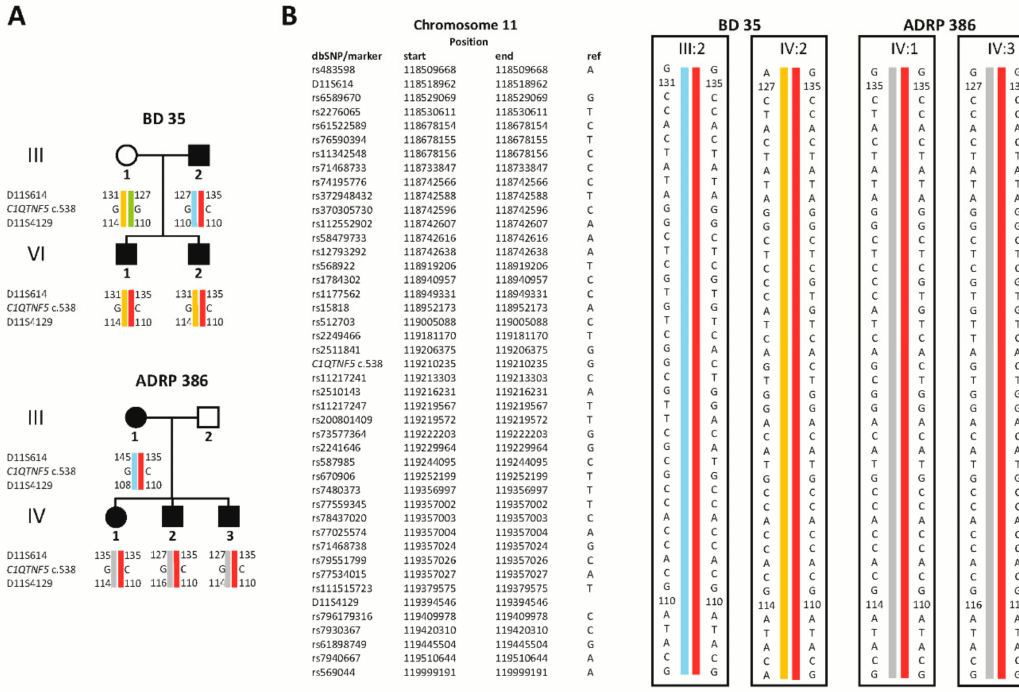
Figure A1. Haplotype analysis showing that the p.(Q180E) variant found in families BD 35 and ADRP 386 is identical by descent. ( A ) Pedigrees showing the core families. Genotypes of the C1QTNF5 variant and two microsatellites surrounding the gene are depicted below the respective pedigree symbols. The shared haplotype of the p.(Q180E) variant is indicated